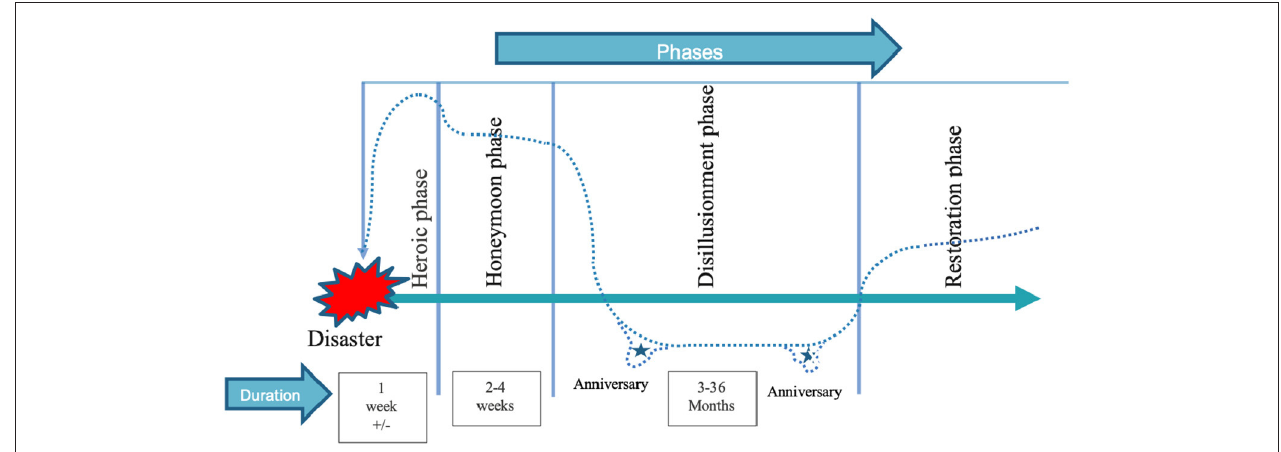
FIGURE 1 | Biopsychosocial response pattern and temporal phases of disaster from Young et al. (34) modified by Math et al. (31,